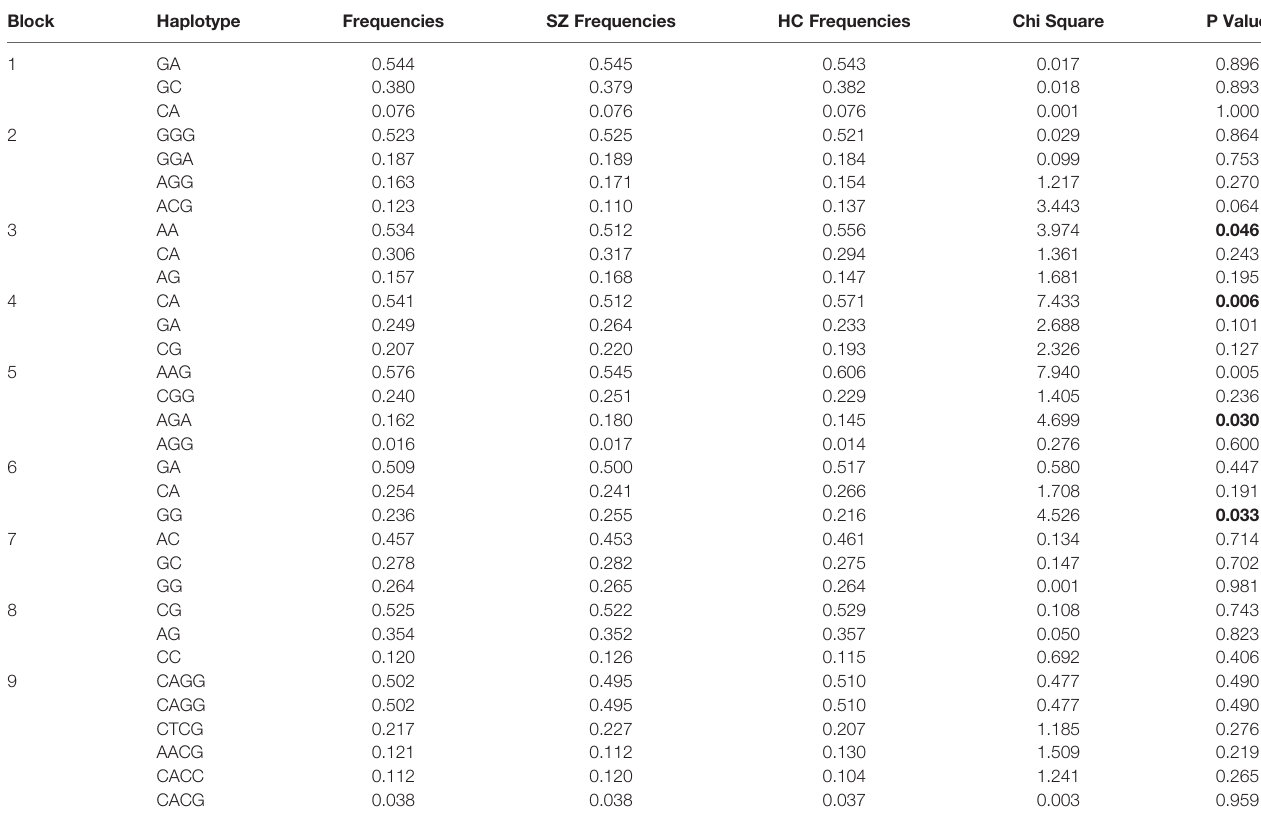
TABLE 3 | Associated haplotype frequencies of 36 SNPs in the SLC1A1 gene between SZ and healthy controls. Block Haplotype Frequencies SZ Frequencies HC Frequencies Chi Square P